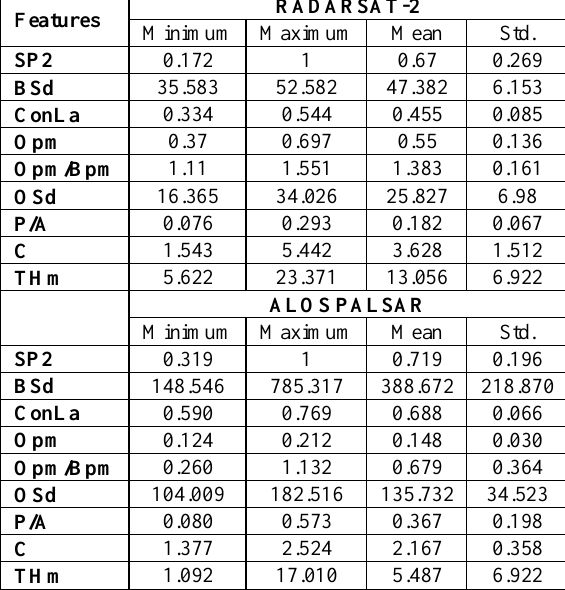
Table 2. Statistics of features obtained from oil objects. Features